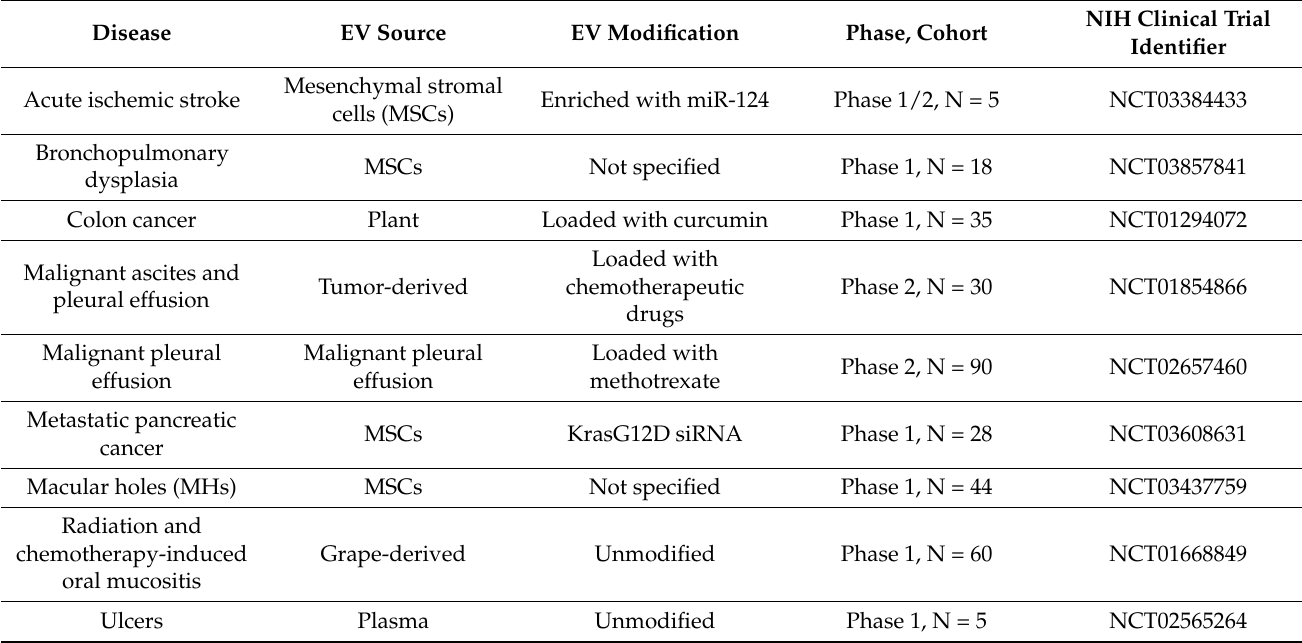
Table 2. Examples of ongoing clinical trials involving EV-based